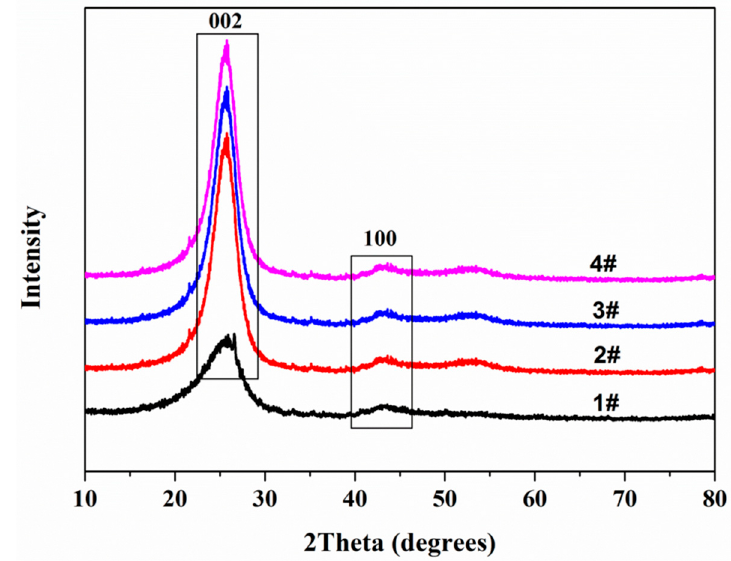
Figure 4. XRD spectra of each carbonaceous deposit layer in the coking chamber.